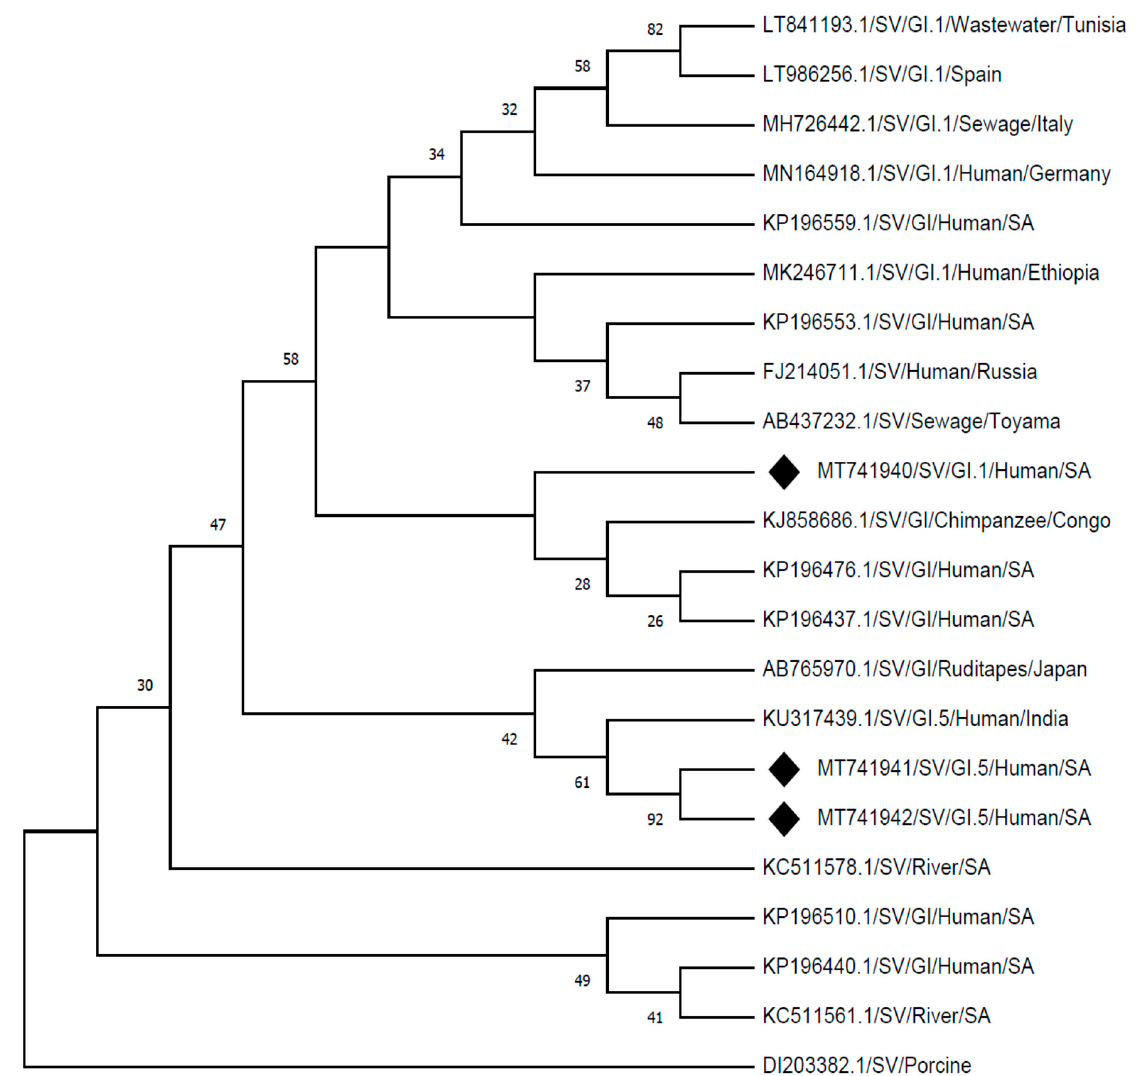
Figure 2. Phylogenetic analysis of the partial nucleotide sequences of sapovirus detected (MT741940, MT741941, and MT741942) in Vhembe district (South Africa), and reference strains of human sapovirus were selected from GeneBank database. Phylogenetic tree was deduced by the Neighbour-Joining method using MEGA X [26], based on a 360 base-pair fragment of the capsid (VP1) region showing the relationships within SV-G1 strains. The porcine SV (DI203382.1) was selected as an outgroup strain.